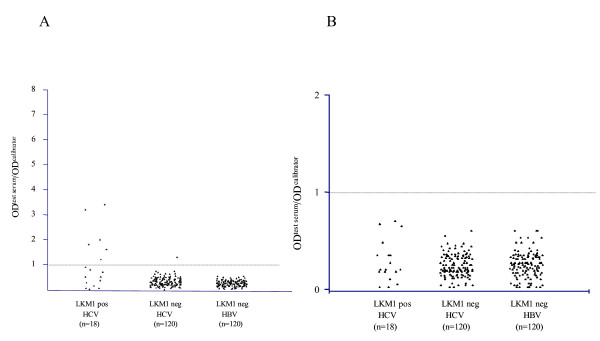
(A). ELISA titers of anti-formimino-transferase cyclodeaminase (anti-FTCD) antibodies, known also as anti-liver cytosolic type 1 antibodies (anti-LC1) and (B). titers of anti-UGA tRNA suppressor associated antigenic protein (tRNP(Ser)Sec) antibodies, known also as anti-soluble liver antigen antibodies (anti-SLA) in 18 liver kidney microsomal type 1 (LKM1) positive chronic hepatitis C virus (HCV) infected patients; 120 LKM1 negative chronic HCV infected patients; and 120 LKM1 negative hepatitis B virus (HBV) infected patients. According to the manufacturer's instructions, autoantibody reactivity is considered positive when optical density (OD)test serum/ODcalibrator > 1.